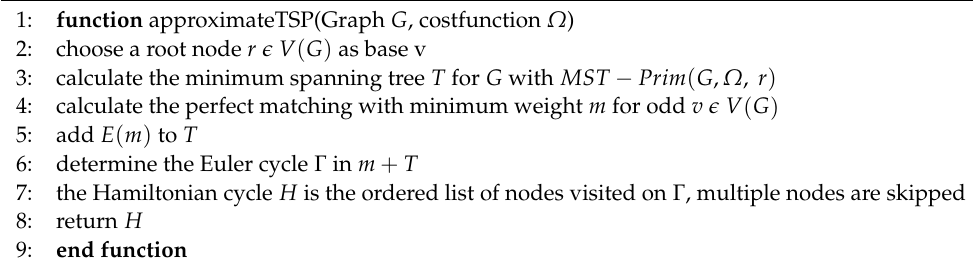
Algorithm 2. Factor 3/2 approximation of the travelling salesman problem